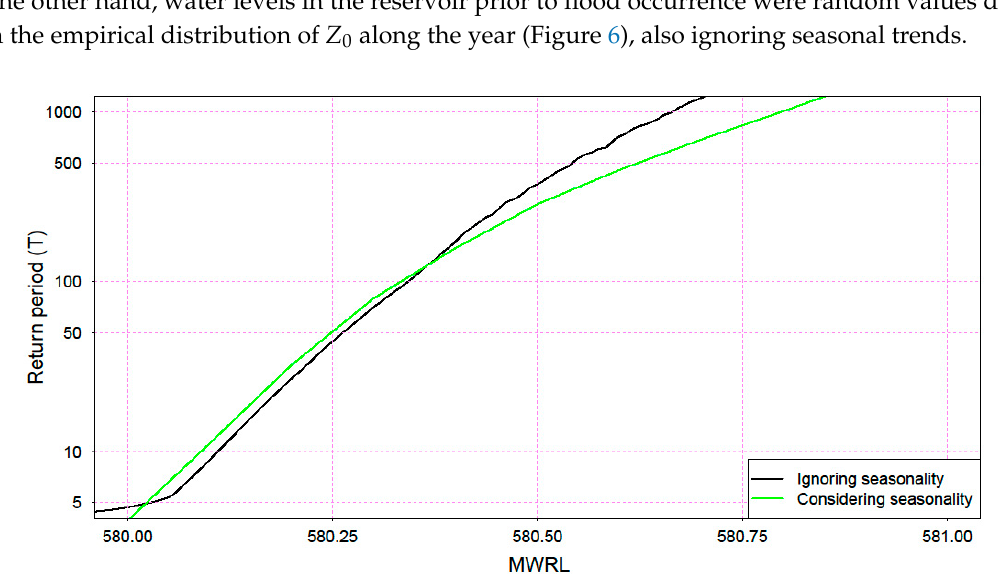
Table 11. Basic statistics for the η coefficient. Variables